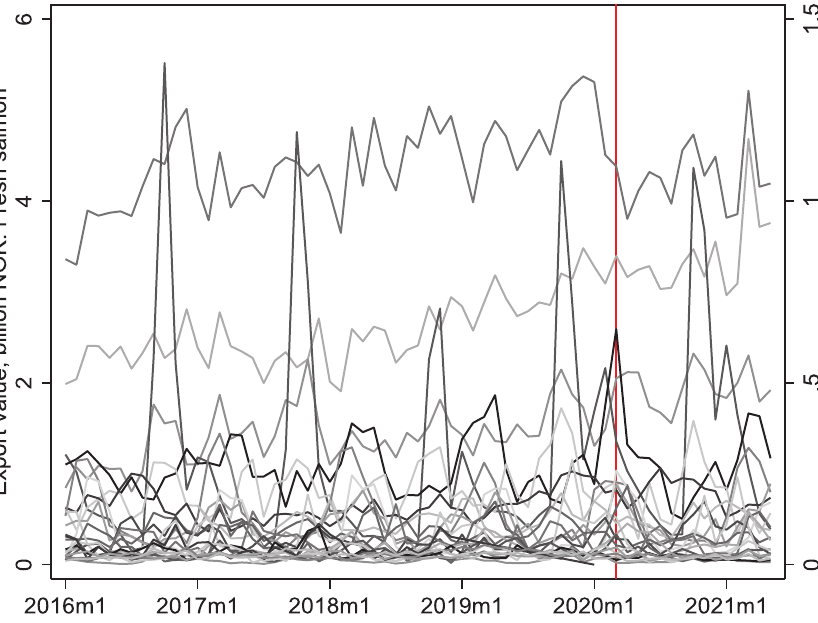
Fig. A1. Export value. All products.